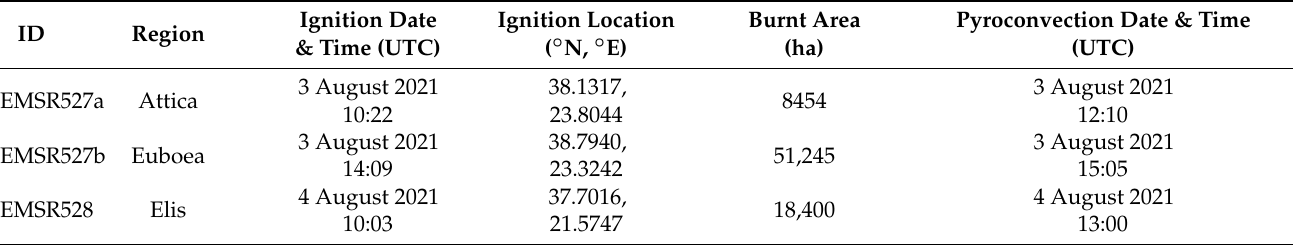
Table 1. Summary of the pyroconvective wildfires examined in the present study. Wildfire IDs are derived from the Copernicus Emergency Management Service [25]. Date and time of ignition provided by the Hellenic Fire Corps (HFC). Burnt area data derived from EFFIS. Pyroconvection date and time refer to the first observation of pyroCu formation as derived from satellite imagery